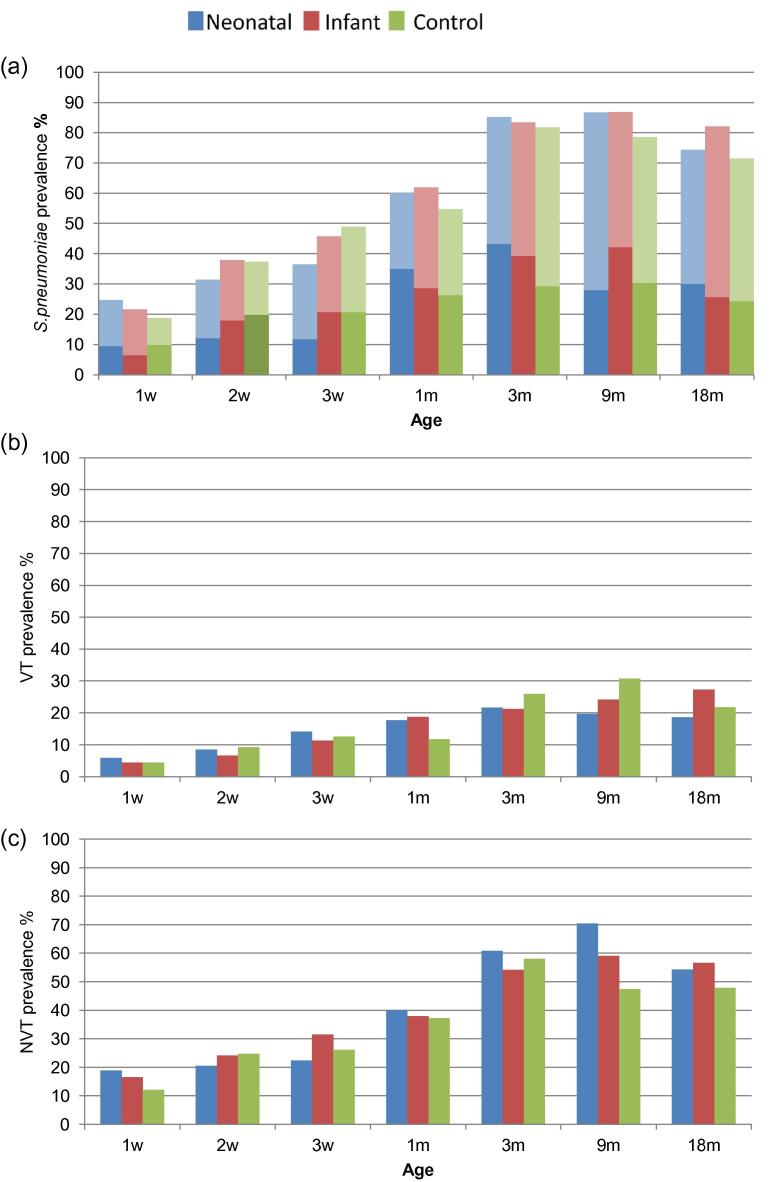
(a) Prevalence of S. pneumoniae carriage, (b) VT (7vPCV) carriage and (c) NVT (non-7vPCV) carriage by age according to vaccine cohort. Dark bars in (a) indicate prevalence of high density carriage.